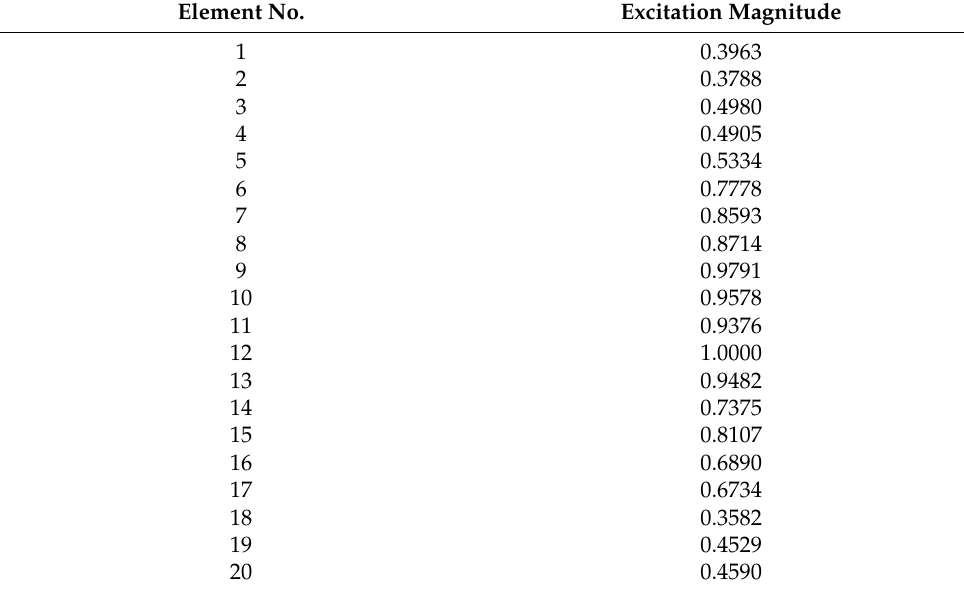
Table 2. The best normalized value of the magnitude of the excitation current of FKE. Element